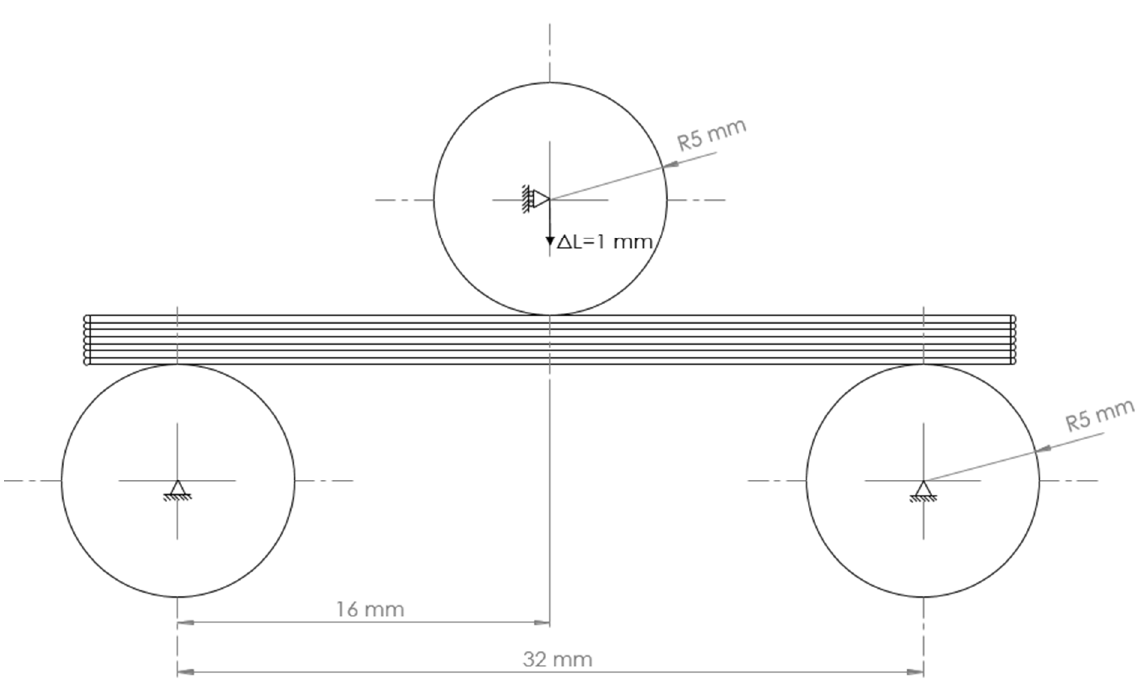
Figure 11. Flexural test of test specimen.